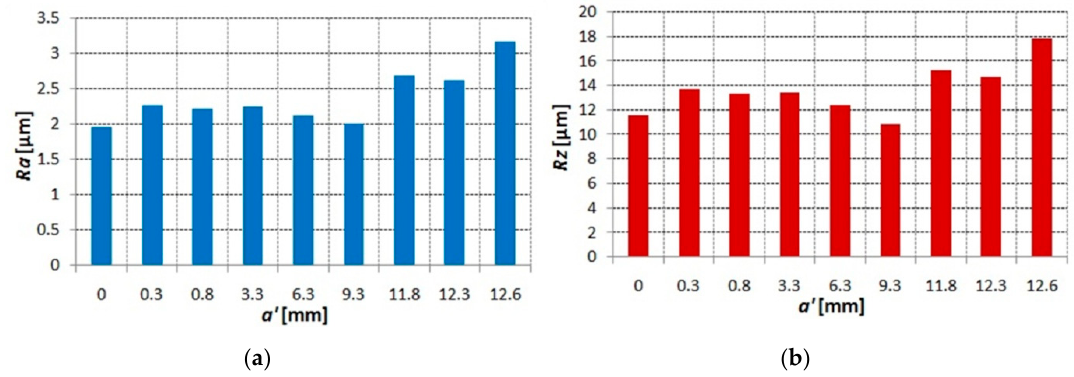
Figure 5. The surface roughness parameter: ( a ) Ra as function of а ′ ; ( b ) Rz as function of а ′ .